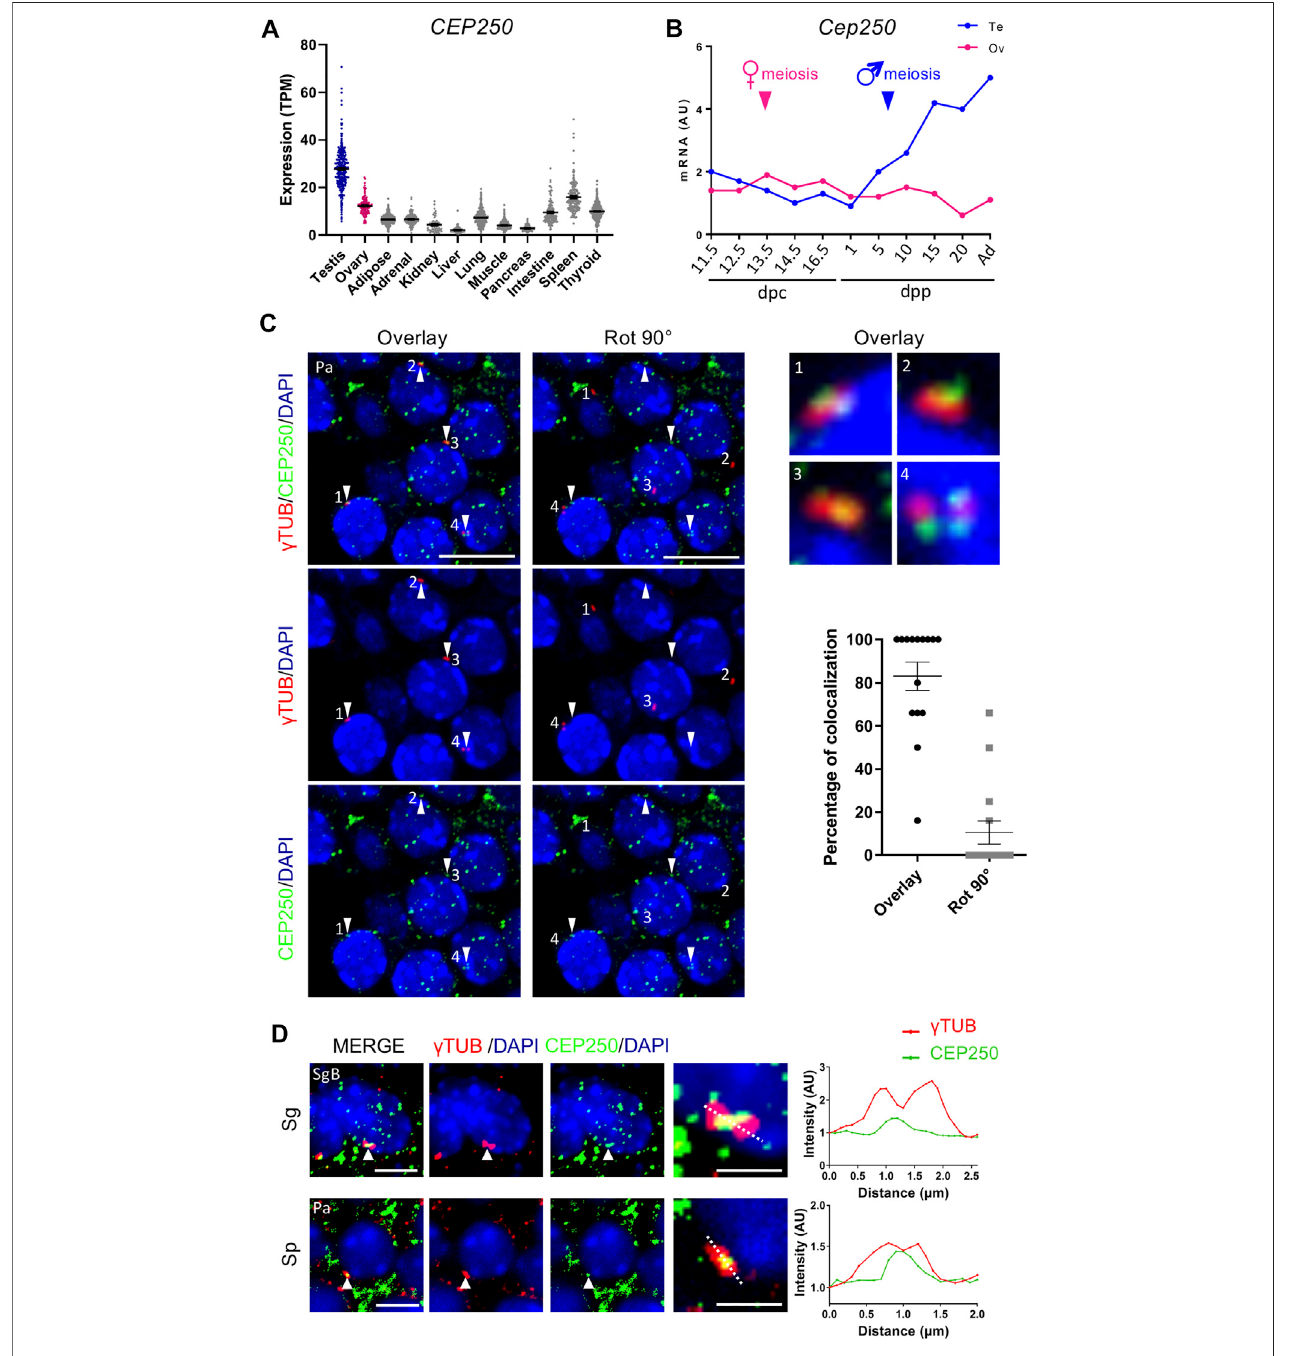
FIGURE 1 | Cep250 is expressed in male germ cells. (A) Expression (Transcripts Per Million, TPM) of Cep250 in different human tissues. (B) Cep250 mRNA expression pattern in mouse gonads. mRNA expression was mesured by RT-qPCR and normalized to β -actin expression in whole fetal and postnatal testes (Te, blue) and ovaries (Ov, magenta) at the indicated developmental ages (days post coitum, dpc; days post-partum, dpp). Values are expressed in Arbitraty Units (AU). (C) Immuno fl uorescence staining of γ -tubulin ( γ TUB, red) and CEP250 (green) in the 15 dpp testis sections. DNA is stained with DAPI. 90 ° clockwise rotation (Rot 90 ° ) of γ -tubulin. White arrowheads indicate CEP250. Numbers indicate γ -tubulin. Magni fi cation of the γ -tubulin and CEP250 stained centrosomes in right images. Right graph quanti fi cation of the γ -tubulin and CEP250 overlay. Each point or square corresponds to the percentage of colocalization per image. Pa: pachytene spermatocytes. Scale bar: 5 µm. (D) Immuno fl uorescence stainingof γ -tubulin ( γ TUB, red) and CEP250 (green) in thespermatogonia (Sg)and spermatocytes (Sp) from 15 dpp testis. DNA is stained with DAPI. Scale bar: 5 µm. Magni fi cation of γ -tubulin-stained centrosomes in the right panel. Scale bar: 2 µm. A dotted line was traced through γ -tubulin-stained centrosomes, and intensities of γ -tubulin (red) and CEP250 (green) were quanti fi ed using the ImageJ software (Plot pro fi le). Values are expressed in Arbitraty Units (AU). SgB, B spermatogonia.